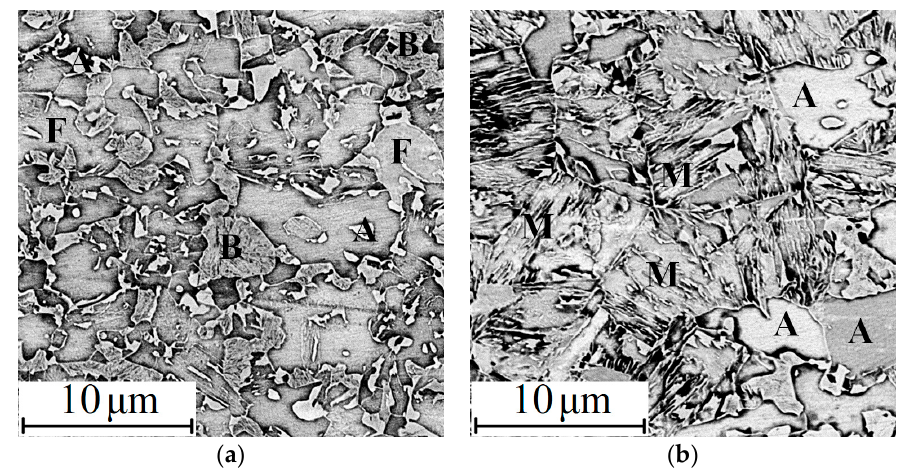
Figure 2. Microstructure of ( a ) TRIP and ( b ) Q&P steels: austenite (A), bainite (B), ferrite (F), and martensite (M).